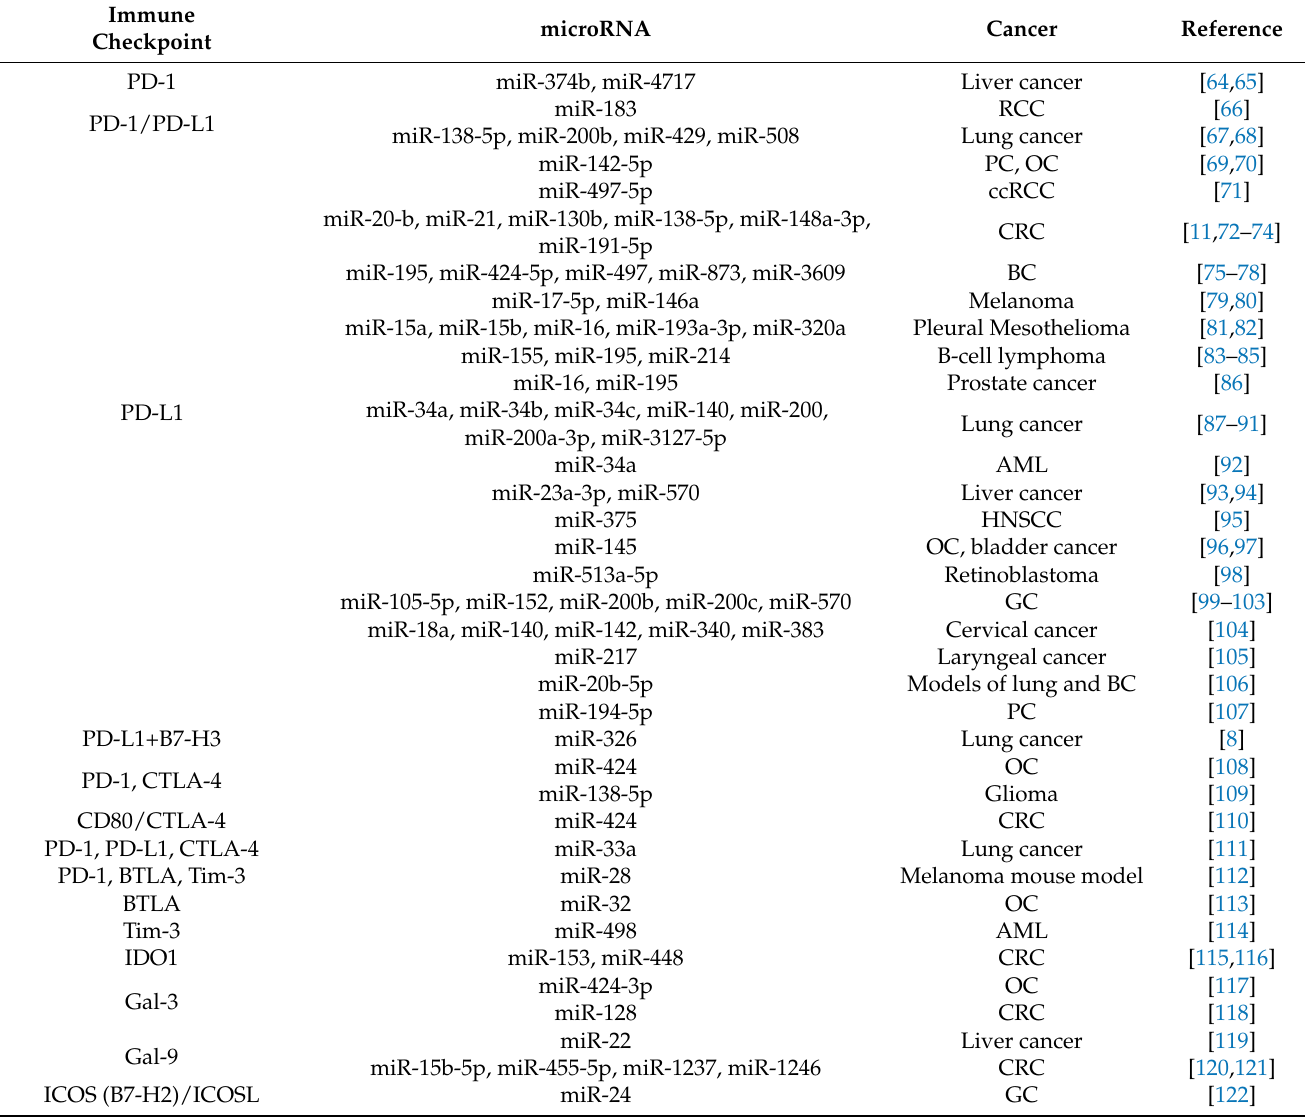
Table 1. The miRNAs interacting with IC genes in different types of